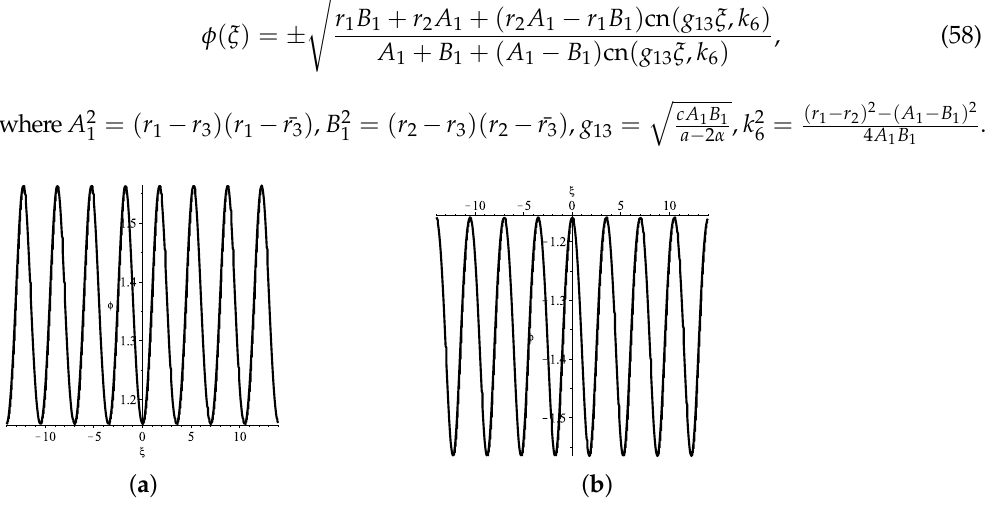
Figure 22. Periodicwave forms of system (5). ( a ) Defined by (58) + . ( b ) Defined by (58) − .